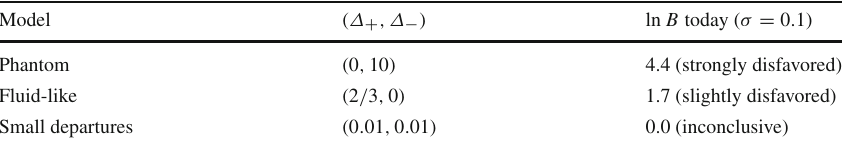
Table1 Strengthofevidencedisfavoringthethreeexamplebenchmarkmodelsagainsta Λ CDMexpansion history, using an indicative accuracy on w = − 1 from present data, σ ∼ 0 . 1